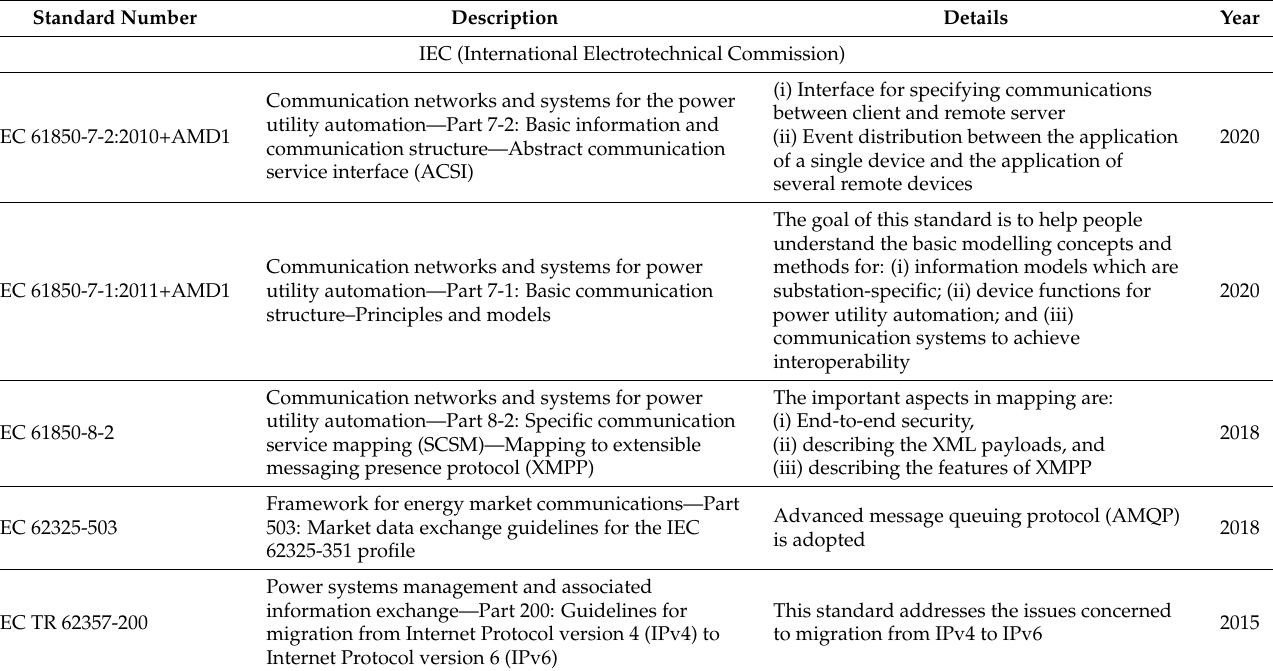
Figure 5. Detailed list of standards and guidelines for smart microgrid communication. Table 6. Various standards and their scope for smart microgrid